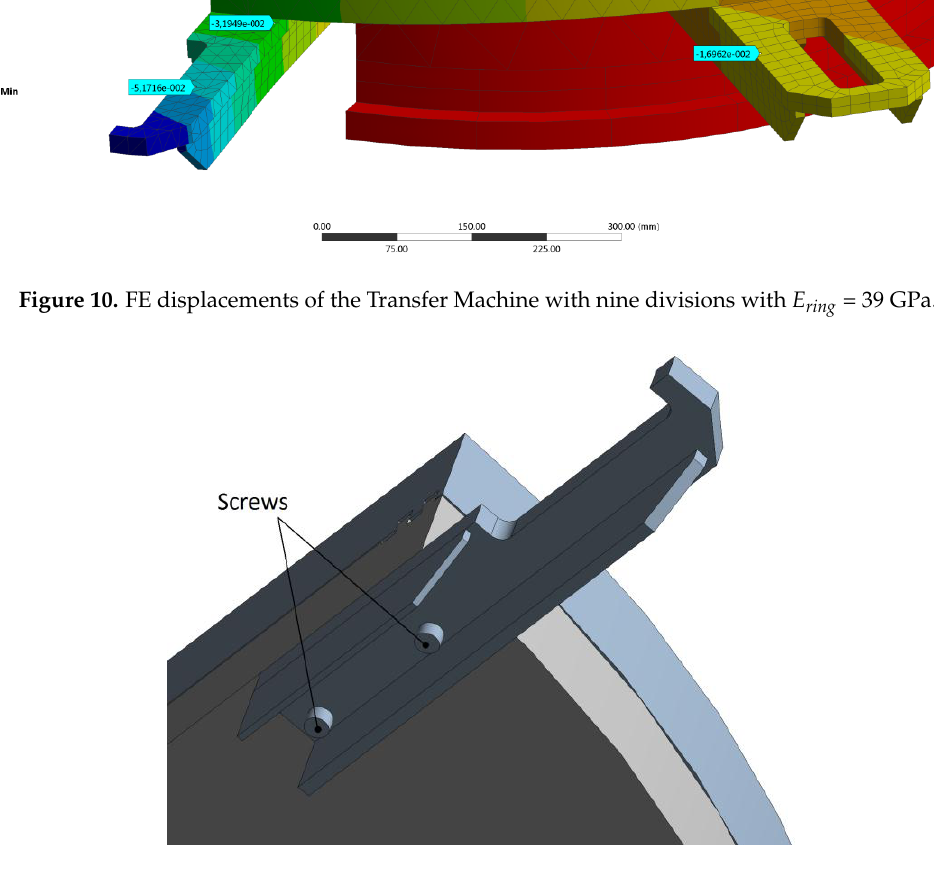
Figure 11. Detail of the bolted connection between the rotary table and the support.